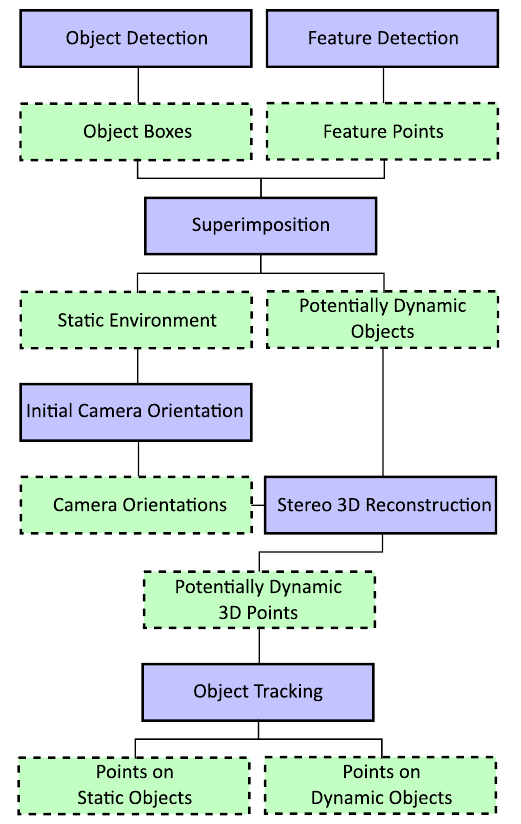
Figure 1. This flowchart shows the procedure used in this paper to identify points on dynamic objects. Blue solid boxes refer to processing steps and green dashed boxes to